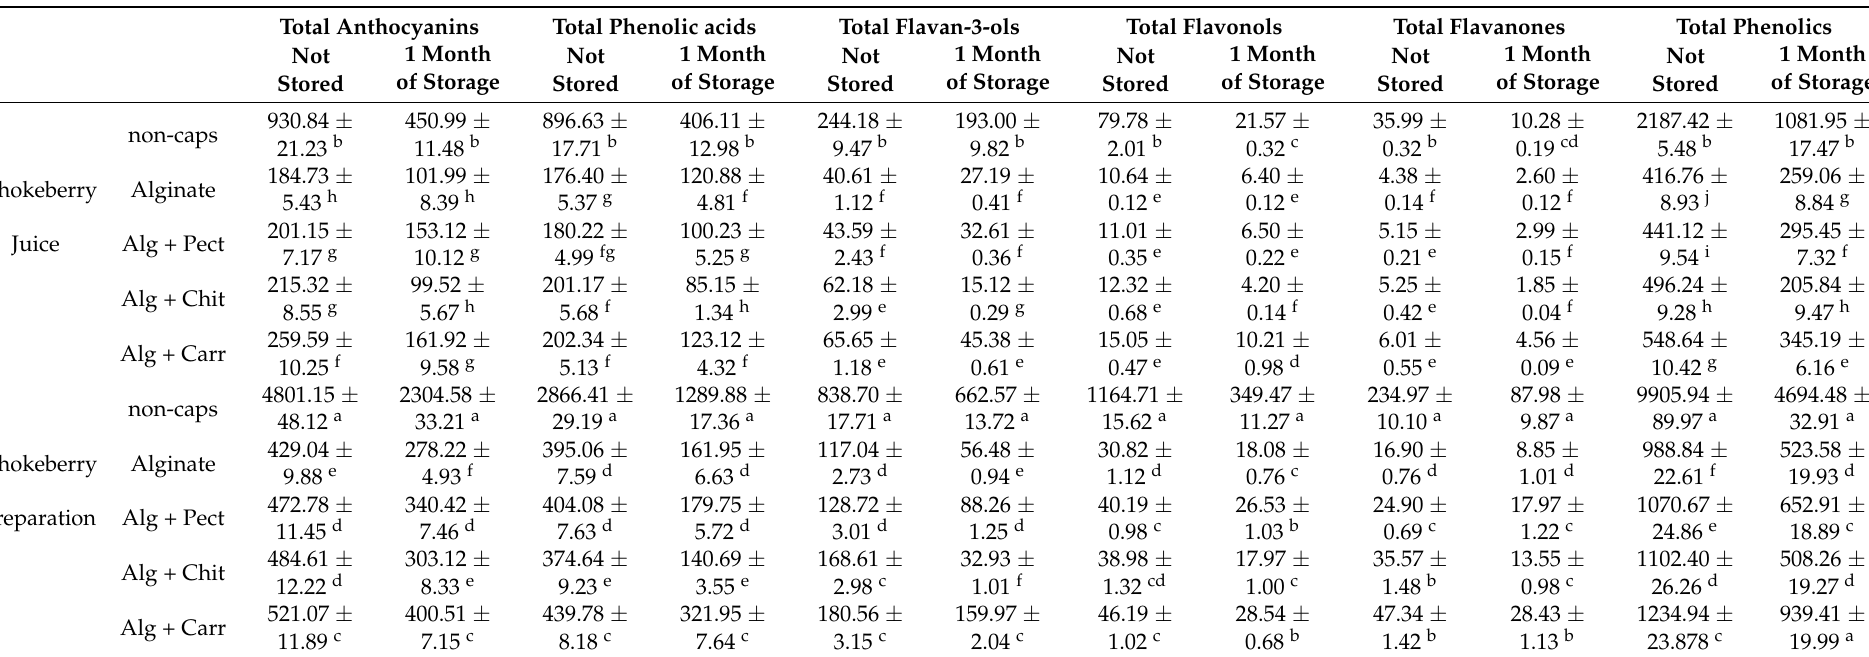
Table 2. Quantity (mg/100 g of product) of phenolic compounds in microcapsules made with chokeberry juice and chokeberry preparation before and after 1 month of storage at 4 ◦